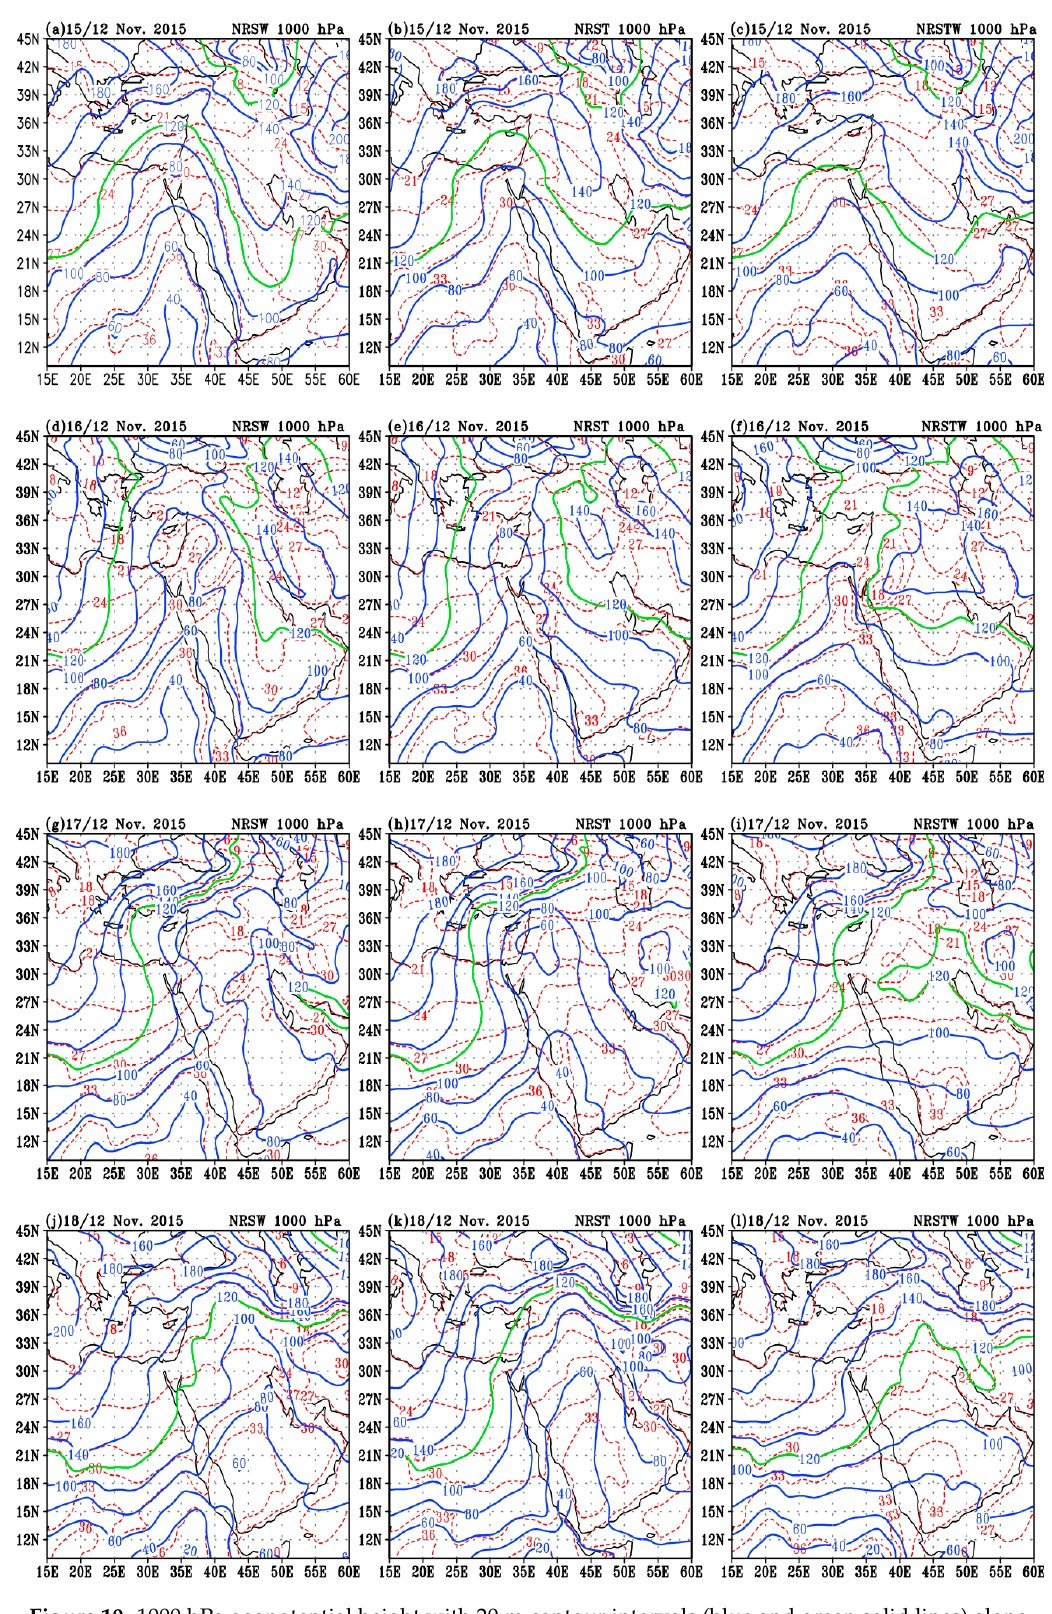
Figure 10. 1000 hPa geopotential height with 20 m contour intervals (blue and green solid lines) along with the temperature (red dashed lines) every 3 °C from the NRSW ( a , d , g , j ), the NRST ( b , e , h , k ), and the NRSTW ( c , f , i , l ) at 12Z for the period of 15–18 November 2015.